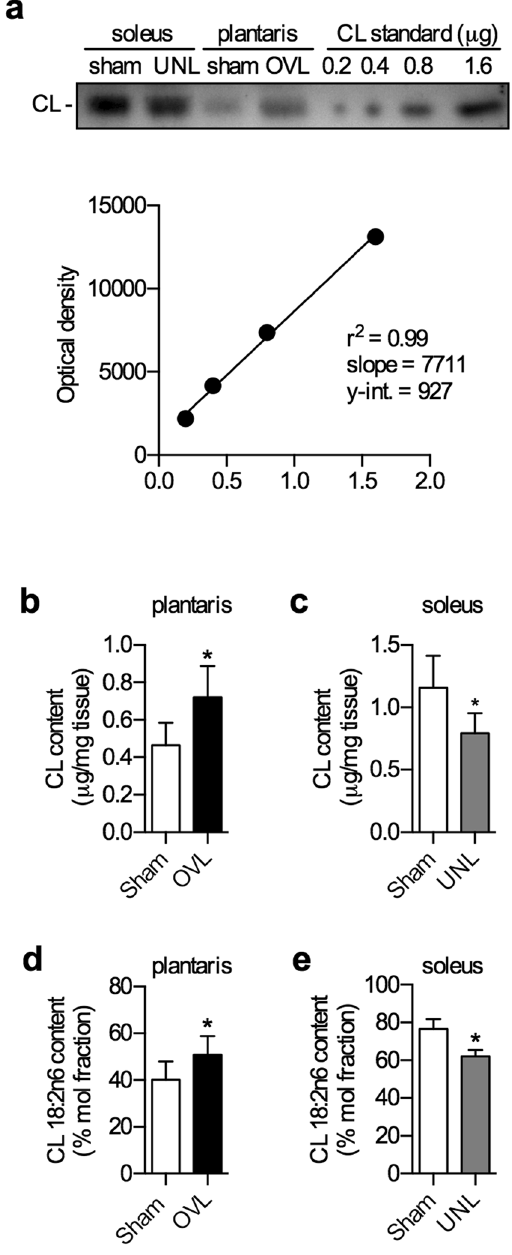
Figure 4. CL content and CL 18:2 n 6 composition are altered in the overloaded (OVL) plantaris and unloaded (UNL) soleus. ( a ) A representative HPTLC chromatogram used to generate a standard curve to quantify the absolute amounts of CL content. CL content is increased in the overloaded plantaris ( b ) and decreased in the unloaded soleus ( c ) muscles compared with their respective shams. CL 18:2 n 6 composition analyzed with gas- chromatography is significantly higher in the overloaded plantars ( d ) and trending to be lower in the unloaded soleus ( e ) compared with their respective shams. * p ≤ 0.05 using a paired t-test (two-tailed), n = 6 per